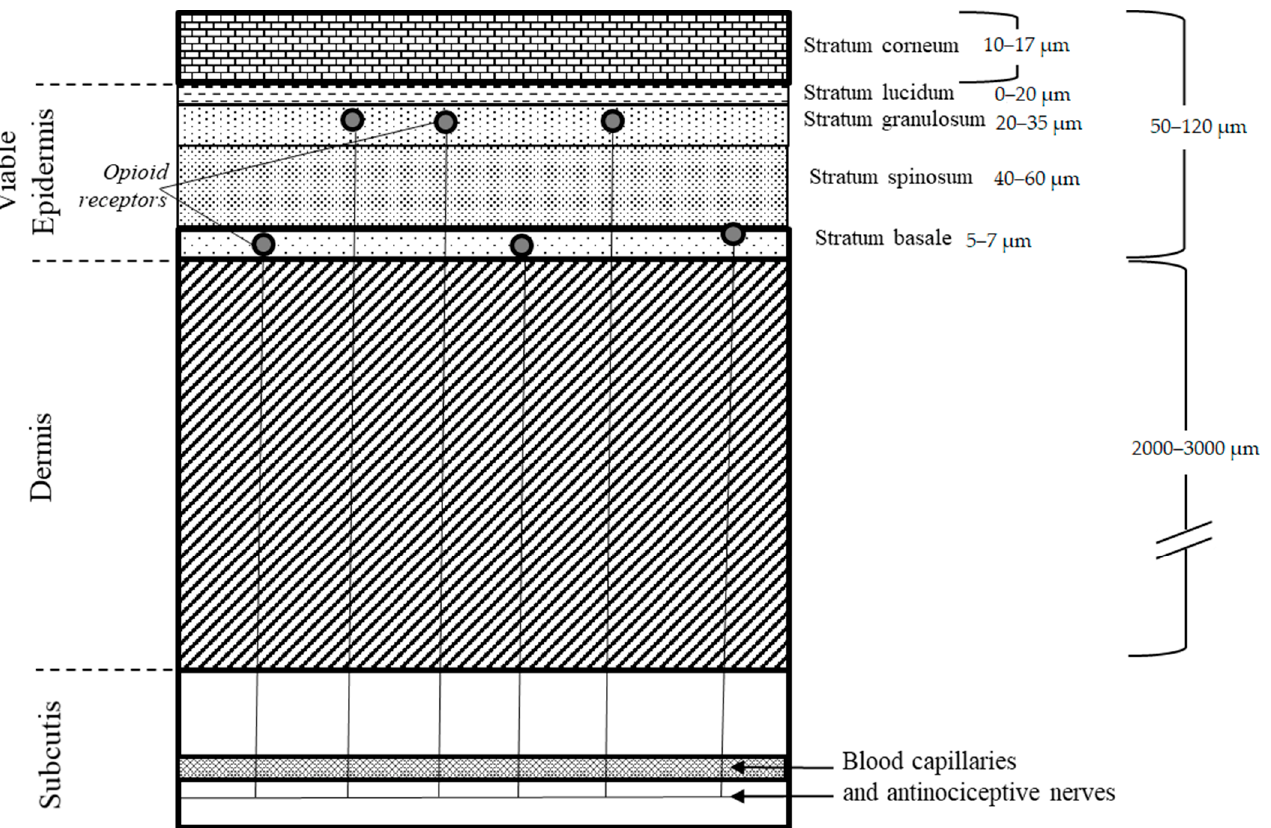
Figure 1. General schematic of the skin layers with peripheral opioid receptors located in the epidermis layer [3,4] .